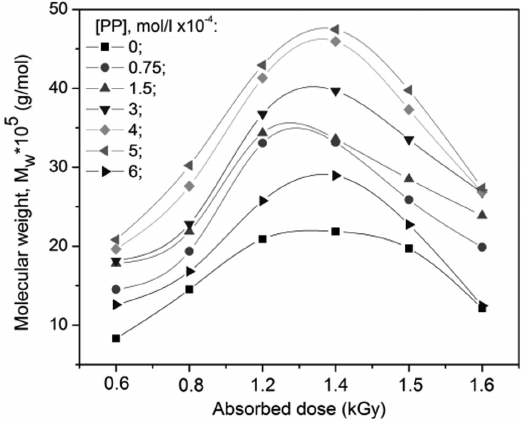
Figure 7. The effect of initiator concentration and EB absorbed dose on molecular weight (M